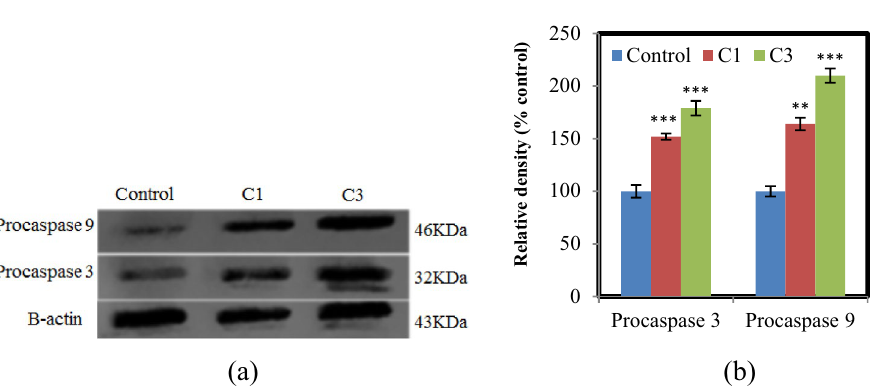
Figure 10. Effect of complexes on the apoptosis protein levels in A375 cells for 24 h. ( a ) Western blot analysis of procaspases 3 and 9 after complex treatment. β − actin was used as an internal control. The blots were cropped before hybridization with antibodies during blotting. ( b ) Densitometric analysis of the expression of procaspase 3 and 9. The percentage values are those relative to the control. Results are the mean ± S.E.M (n = 3) * p < 0.05, ** p < 0.01, *** p <